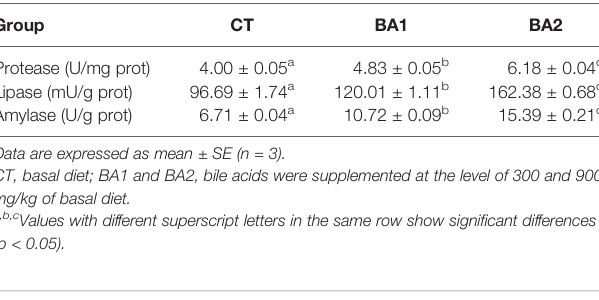
TABLE 7 | Effects of dietary bile acids on liver antioxidant capacity in tongue sole.